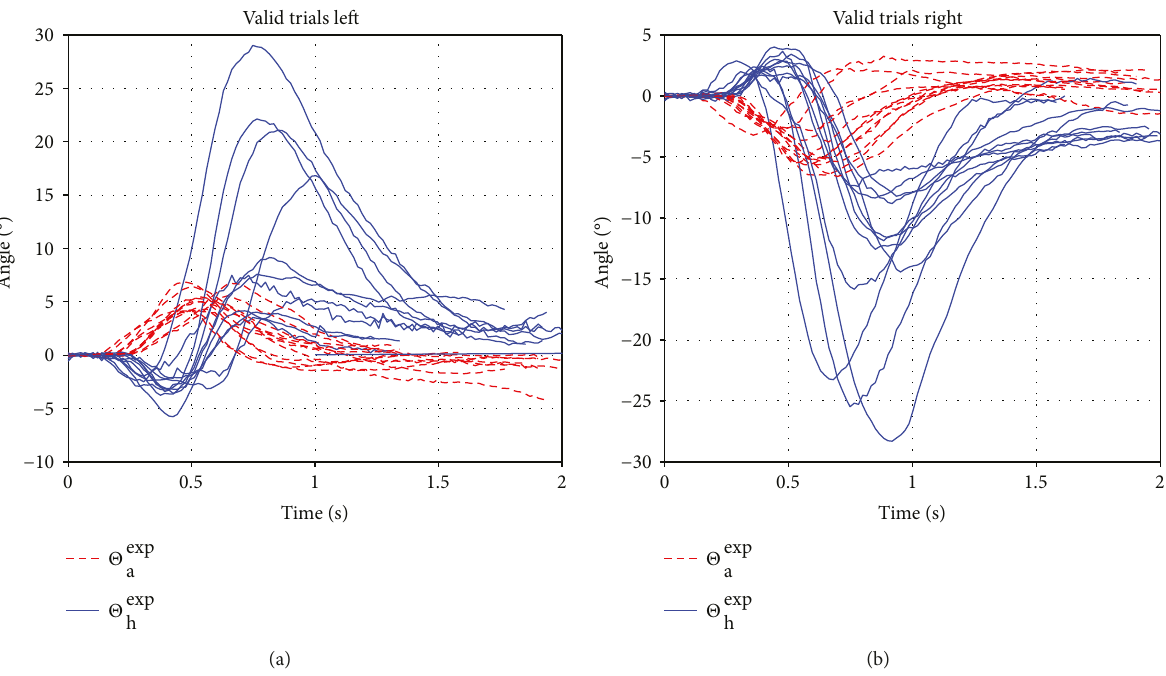
Figure 5: Un fi ltered angular trajectories for valid trials of the experiment. In the (a) plot are the perturbations to the left, and in the (b) are perturbations to the right. The solid line (blue) is the hip the dashed line (red) is the ankle angle trajectory. All the “ extreme ” hip angle peaks stem from participant